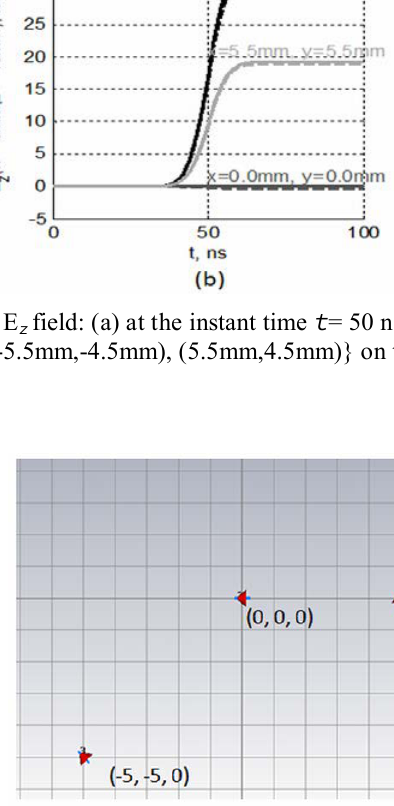
Figure 21: CST MWS simulation setup for the three dipoles from Figure